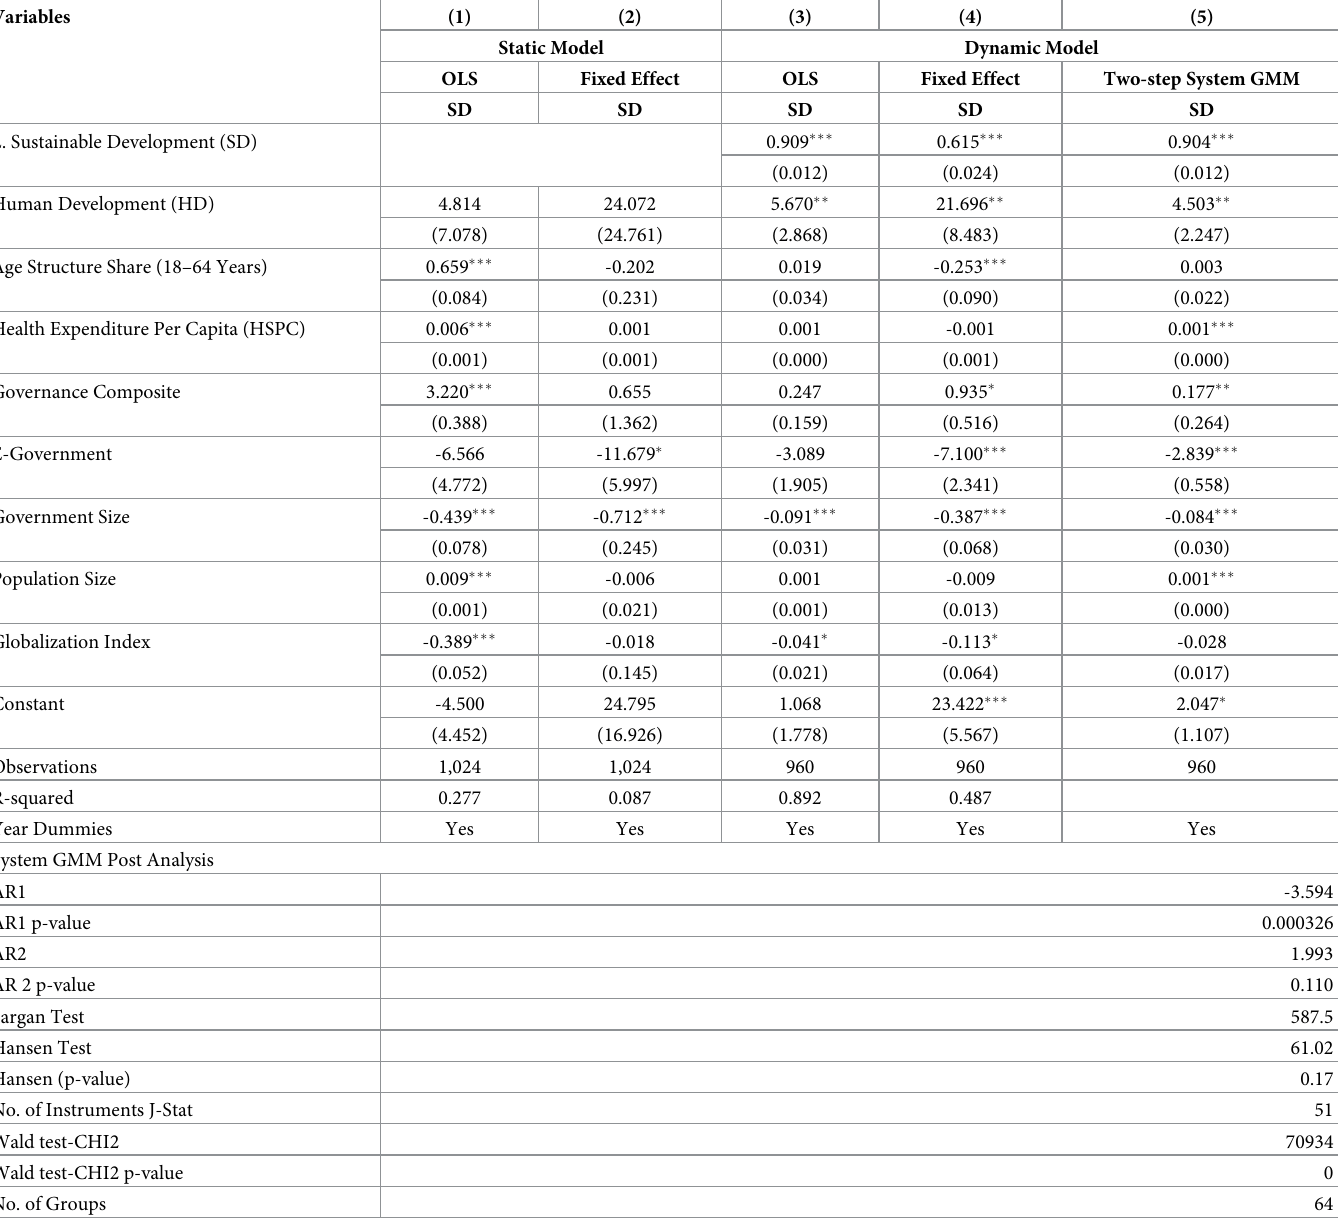
Table 3. Results of direct impact- two-step system generalized methods of moment